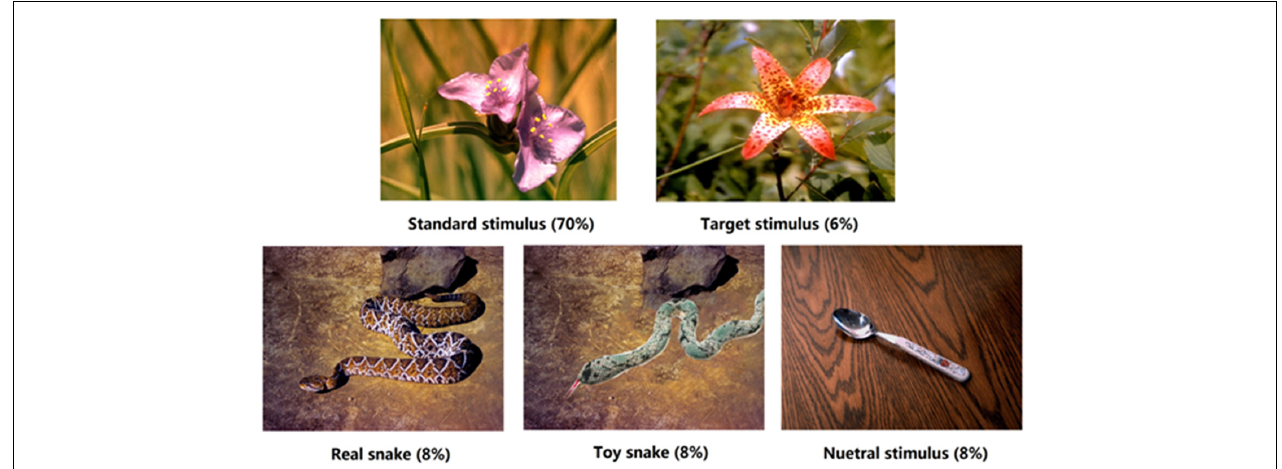
FIGURE 1 | Schematic diagrams of the five types of stimuli. Each block contained 200 trials in total, such as standard stimulus 140 times (70%), target stimulus 12 times (6%), and each type of bias stimulus 16 times (8%), respectively.